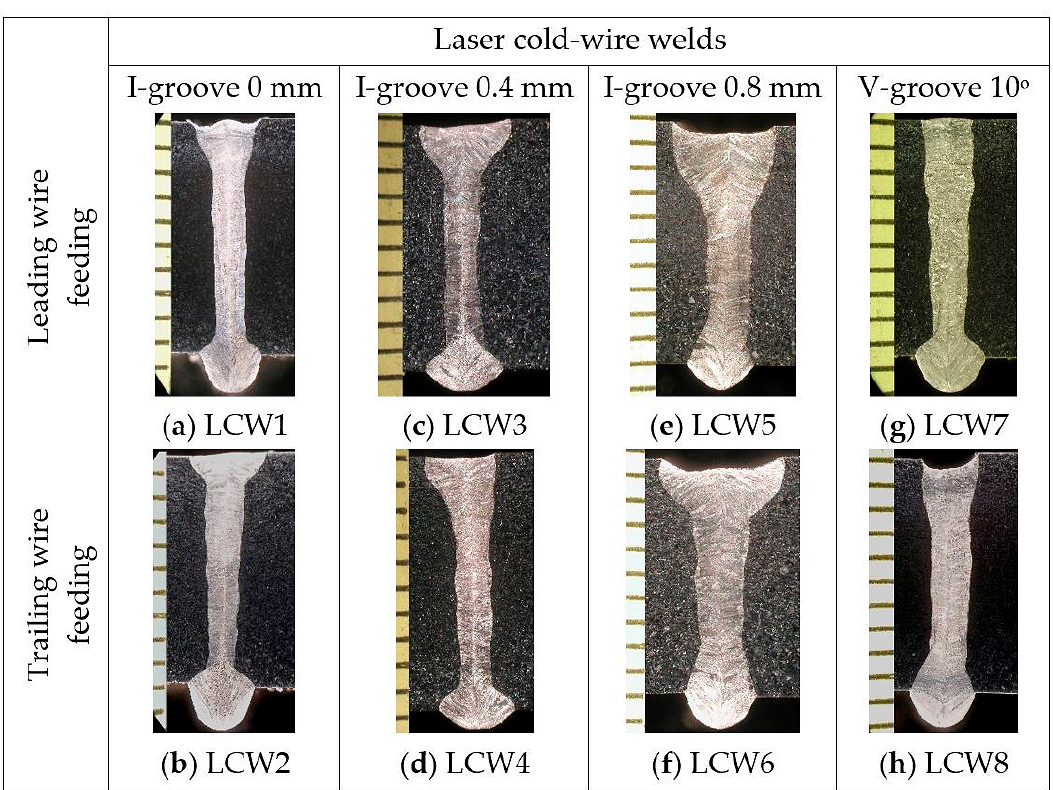
Figure 8. Weld cross-sections ( a – h ) from laser cold-wire welding tests.